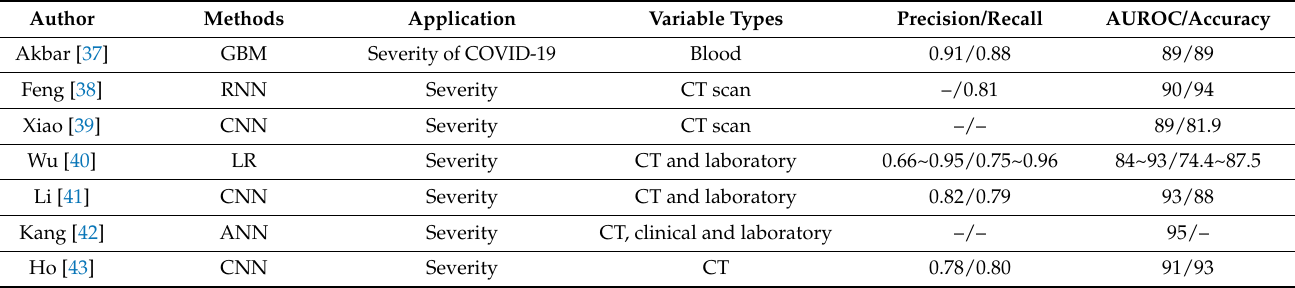
Table 2. The performance of AI model to predict disease severity of patients with